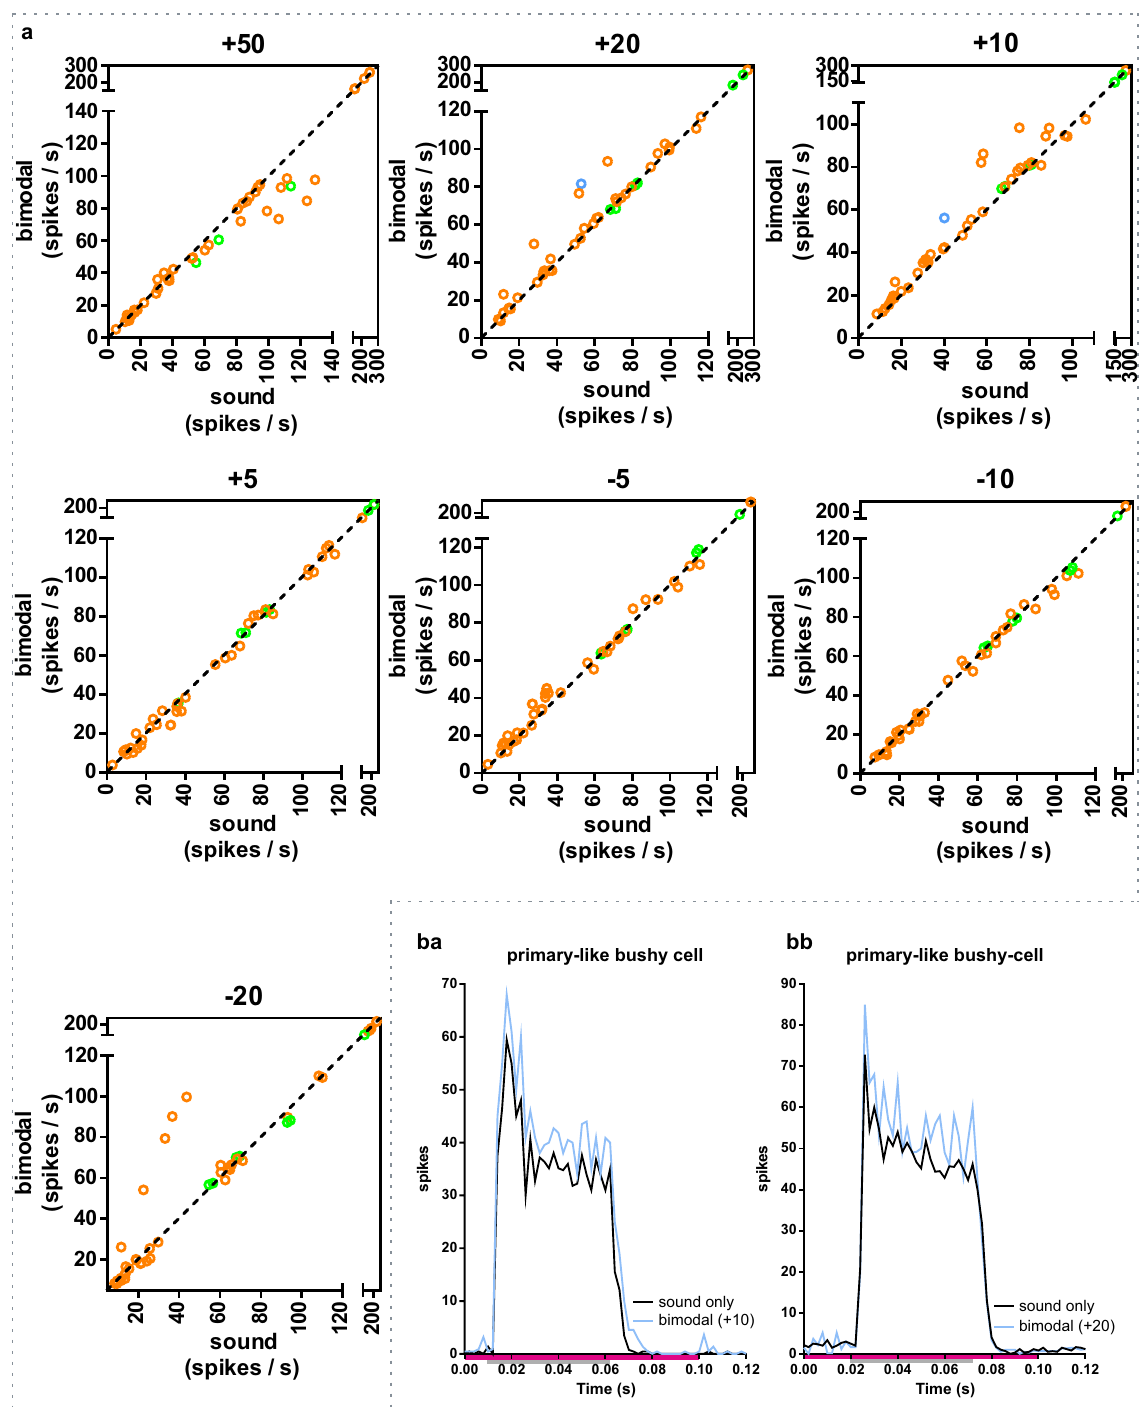
Figure 4. Bimodal response in bushy cells. ( a ) Bimodal stimulation compared to sound stimulation. Each protocol (+ 50, + 2 + etc.) is plotted separately and each spike-sorted unit is represented with a circle (PL: n = 42; PLN: n = 7). The dotted line represents a linear regression line with slope 1 (y = x). Orange circles (n = 42) are primary-like bushy cells and green circles (n = 7) are primary-like-with-notch bushy cells (PLNs). In PL cells the bimodal + 20 & + 10 stimulation protocols evoked a larger response compared to only sound (Table 2). Blue circles are the example cells from ba-bb . 5 PL bushy cells showed an increase of the bimodal response compared to the sound only stimulation with the − 20 protocol. ( ba ) PSTH for a primary-like bushy cell for the protocol + 10. The bimodal response is increased compared to the only sound response. Pink bar shows the time of whisker stimulation (from 0 to 0.10 s); the grey bar marks the duration of the sound stimulation (from 0.01 to 0.06 s; sum of 500 stimulations each for sound and bimodal). ( bb ) PSTH for a primary-like bushy cell for the protocol + 20. The bimodal response is increased compared to the only sound response. Pink bar shows the time of whisker stimulation (from 0 to 0.20 s); the grey bar marks the duration of the sound stimulation (from 0.02 to 0.07 s; sum of 500 stimulations each for sound and